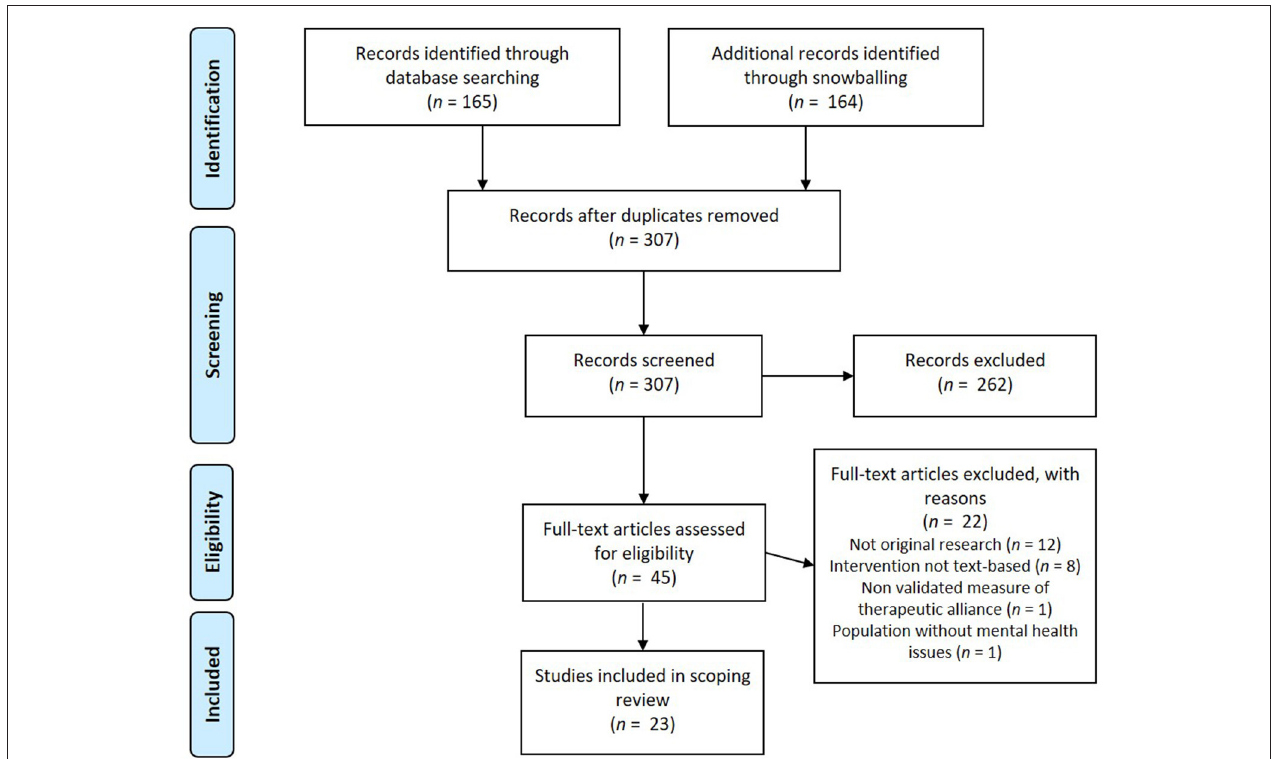
FIGURE 1 | PRISMA flowchart (26) of the inclusion/exclusion process of articles for the systematic literature